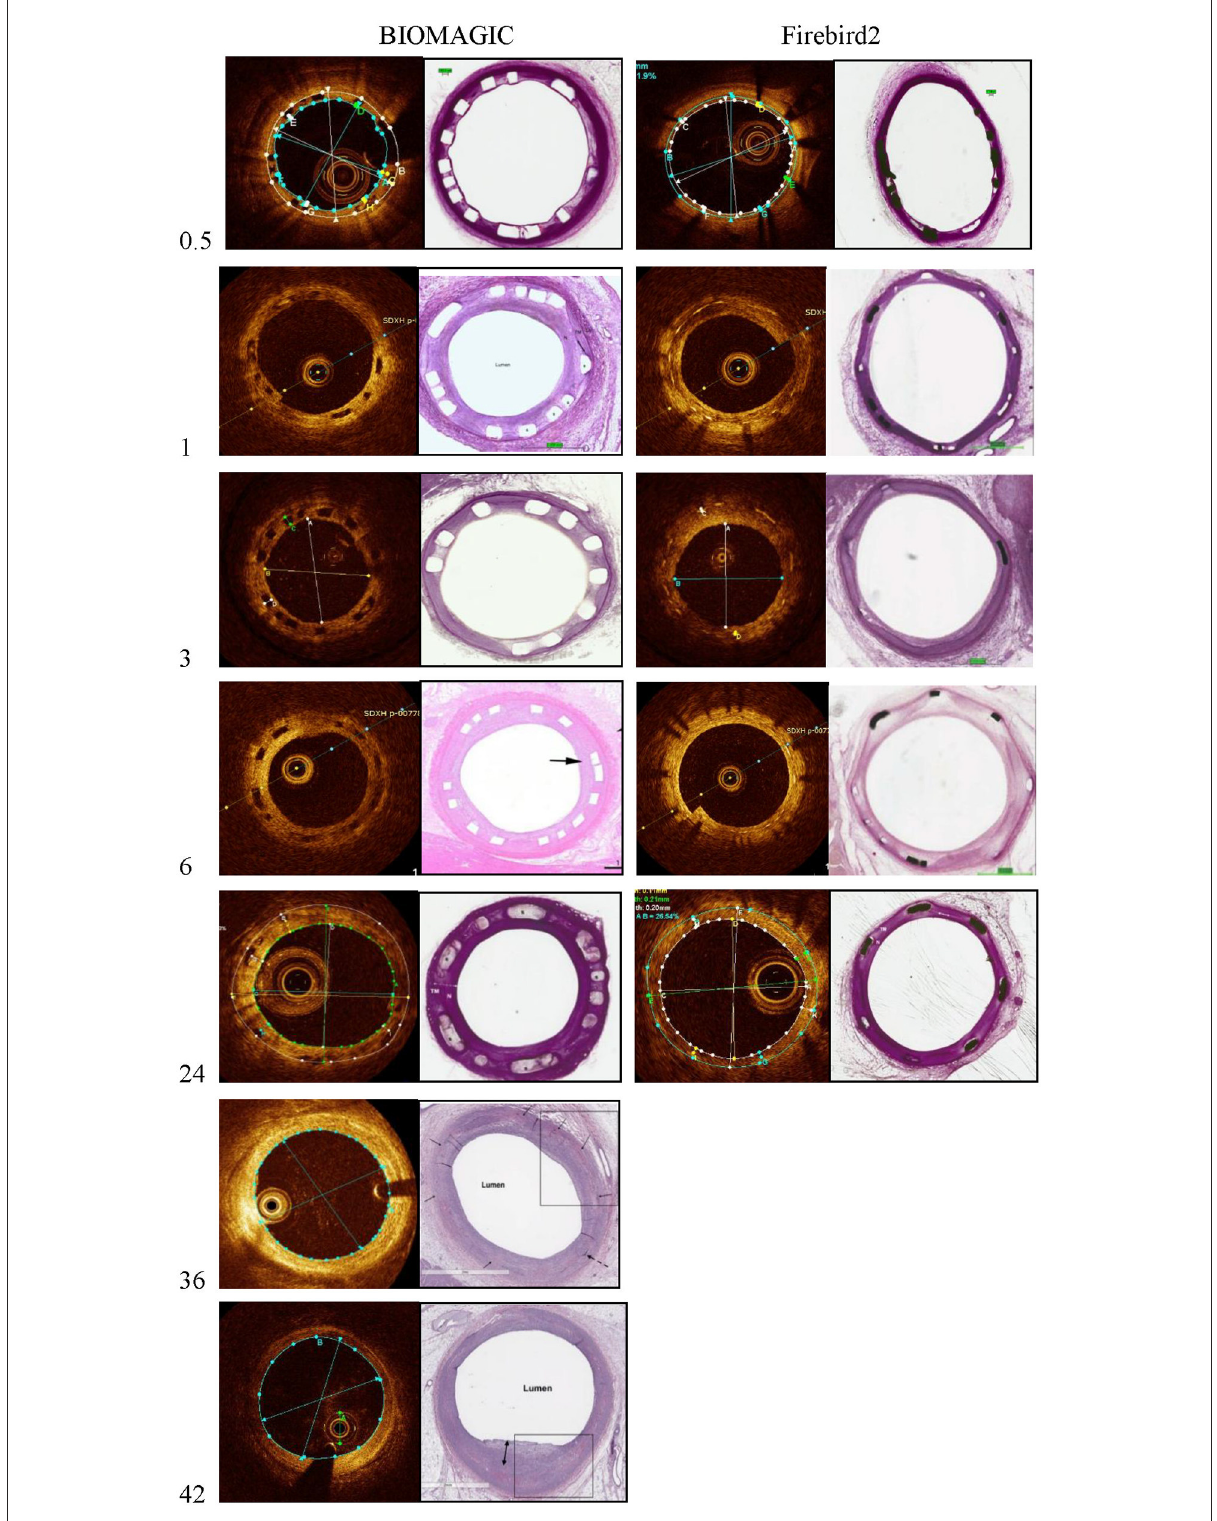
FIGURE1 Representative photomicrographs and OCT still frames of Biomagic and Firebird2-implanted porcine coronary arteries evaluated from 1 to 42